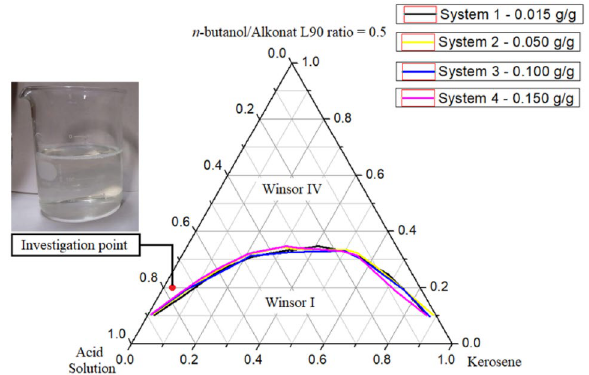
Fig. 2 Pseudo-ternary diagrams of the microemulsion systems with different